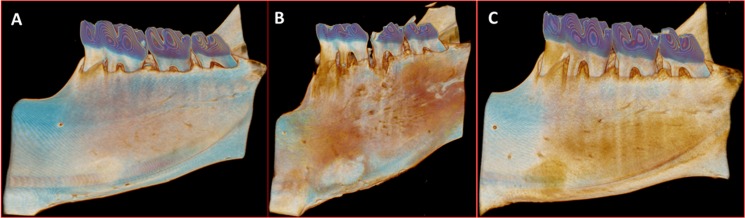
The 3D representative images of each group.A- NL group. B- LO group. C- H group.